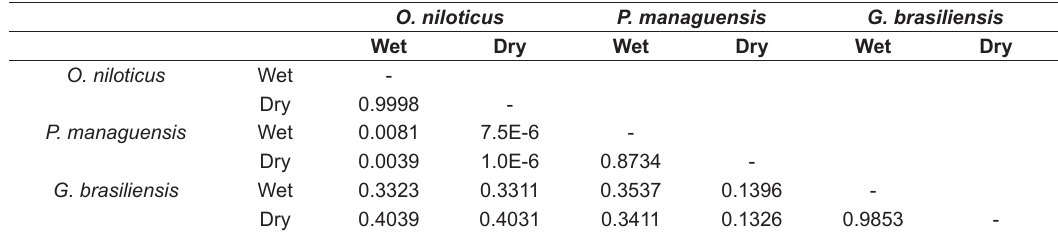
Table 4. Pianka’s overlap index of diet across fish species and seasons during the study